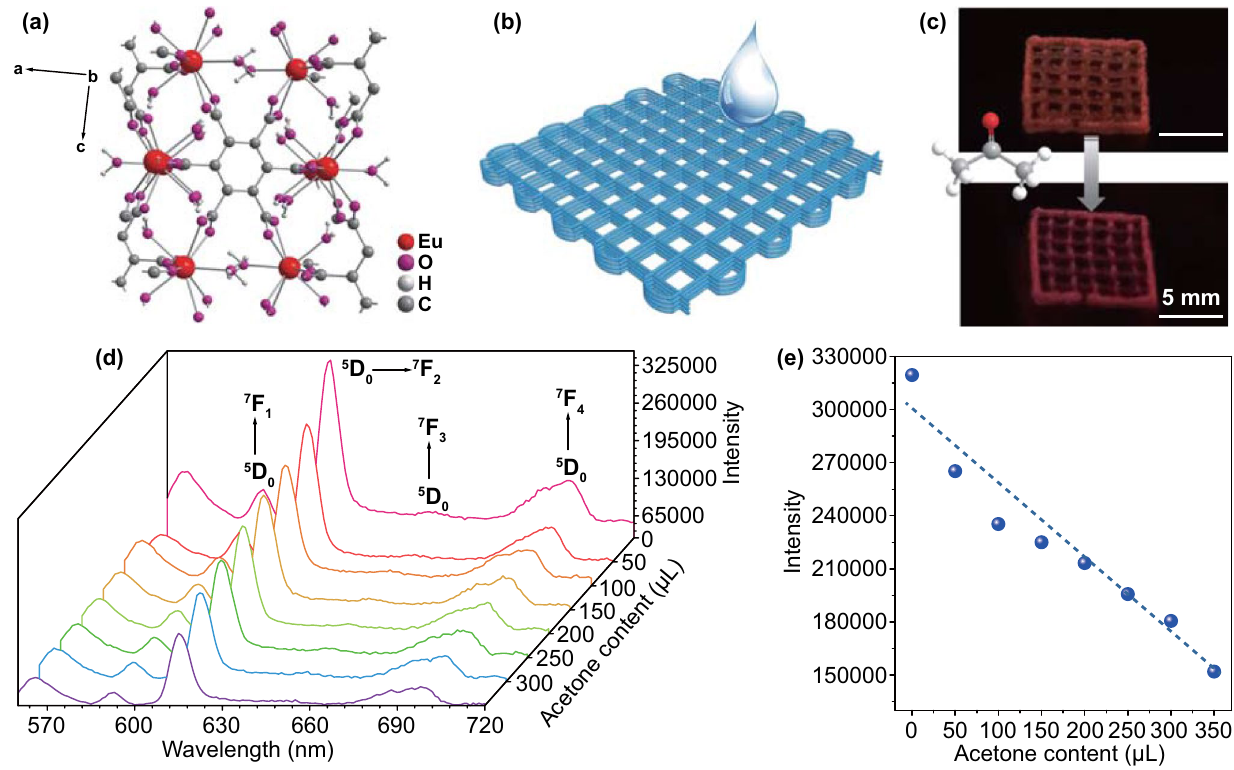
Fig. 5 Proof-of-concept demonstration of optical sensing platform. a Molecular structure of EuMOF obtained from single-crystal crystallog- raphy. b 3D-printed architecture of the optical sensing system. c Photographs of fluorescence quenching can be seen by the naked eye in the case of colorimetric response. d Photoluminescence spectra of Alg-EuMOF-4 and e the corresponding 5 D 0 → 7 F 2 transition intensity changes in response to various content acetone ( λ exc = 254